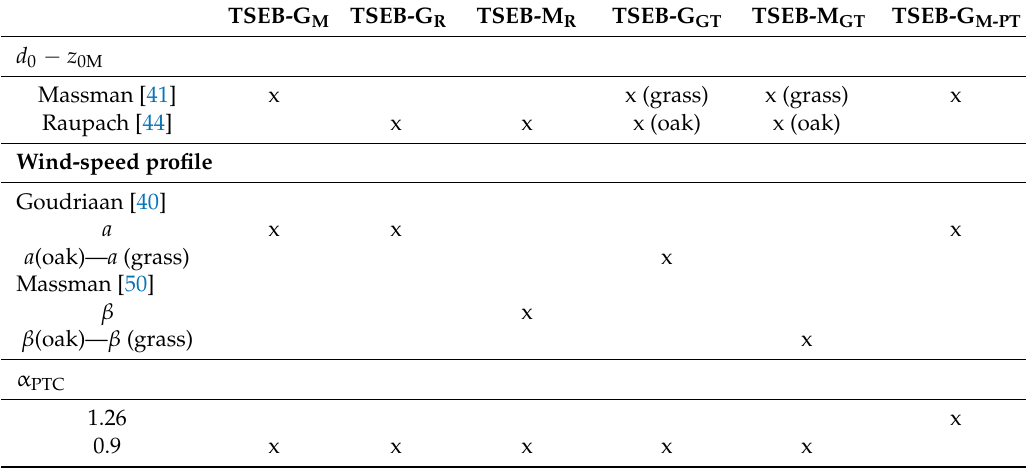
Table 1. Defining the acronyms for the different TSEB computations based on estimates of d 0 and z 0M using Massman [41] for grass or combined grass-oak system, or Raupach [44] for oak or combined grass-oak system, wind-speed profile in the canopy layer using Goudriaan [40] or Massman [50] and α PTC = 1.26 or